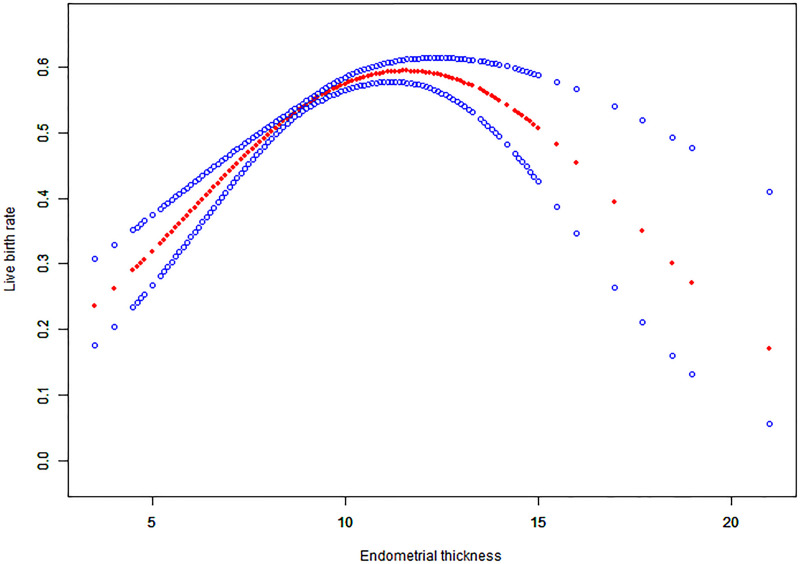
Associations between endometrial thickness and live birth rate of HRT-FET cycles.The threshold was identified, and a nonlinear association between endometrial thickness and the live birth rate was found (P<0.001) using a GAM. The solid-dotted red line represents the smooth curve that fits between variables. Blue curves represent the upper and lower limits of the 95% CI. All were adjusted for age, the duration of infertility, body mass index, infertility type, and the number and type of embryos transferred.